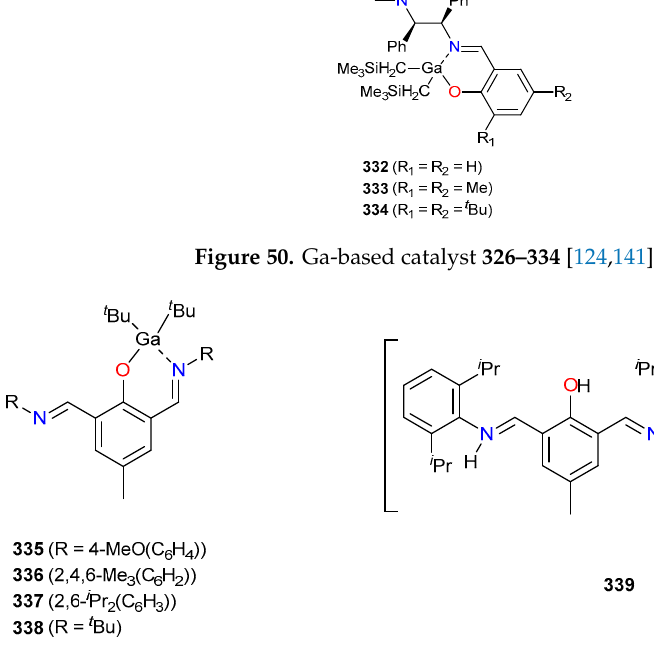
Figure 50. Ga-based catalyst 326–334 [124,141].